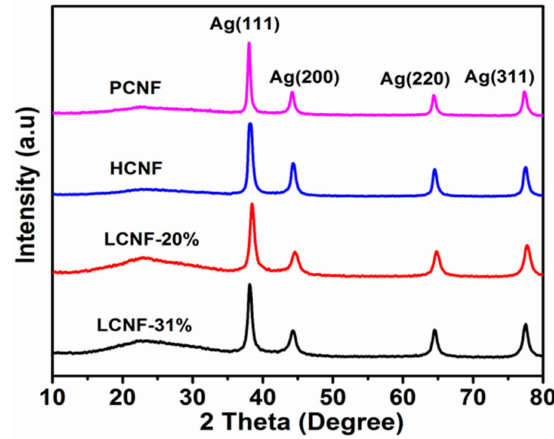
Figure 3. XRD patterns of AgNPs adsorbed on di ff erent CNFs at 45 ◦